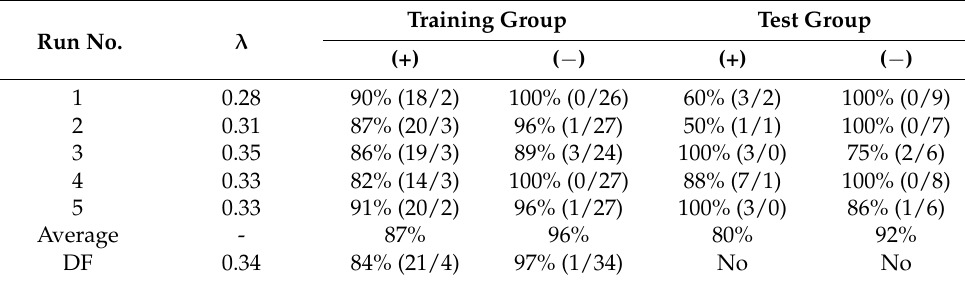
Table 3. Results of the internal validation for